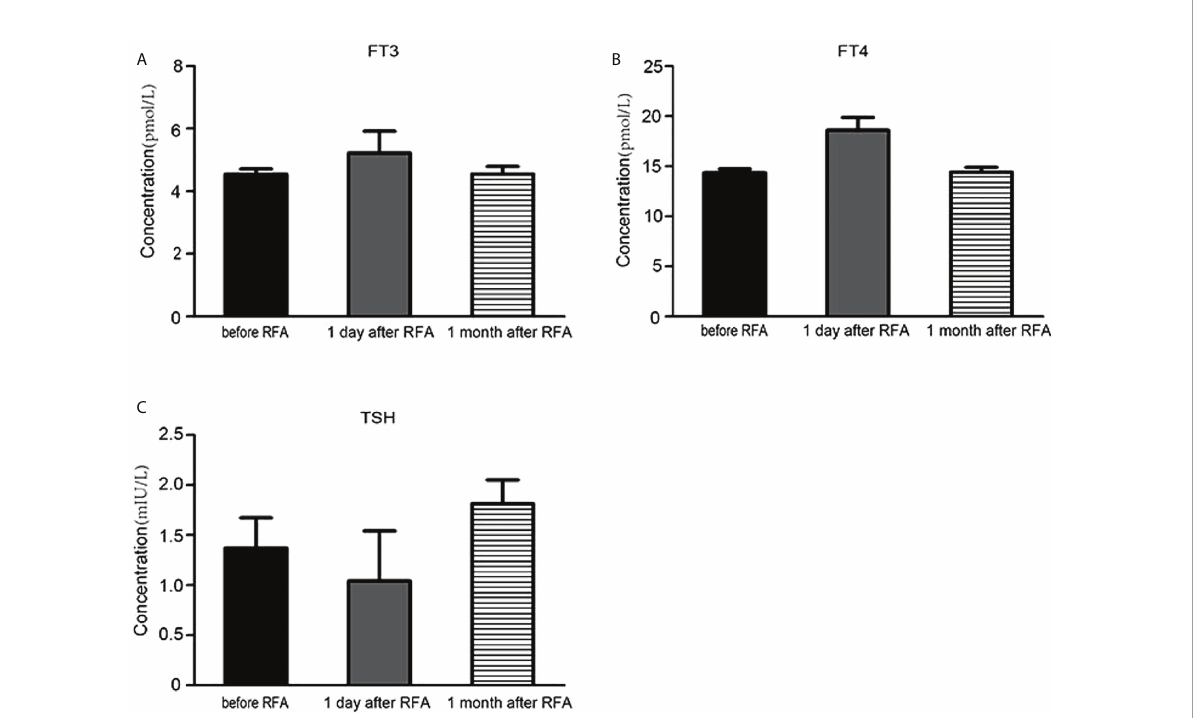
FIGURE 4 The in fl uence of radiofrequency ablation on the thyroid function. (A) The serum FT3 concentration before radiofrequency ablation, 1 day and 1 month after radiofrequency ablation. (B) The serum FT4 concentration before radiofrequency ablation, 1 day and 1 month after radiofrequency ablation. (C) The serum TSH concentration before radiofrequency ablation, 1 day and 1 month after radiofrequency